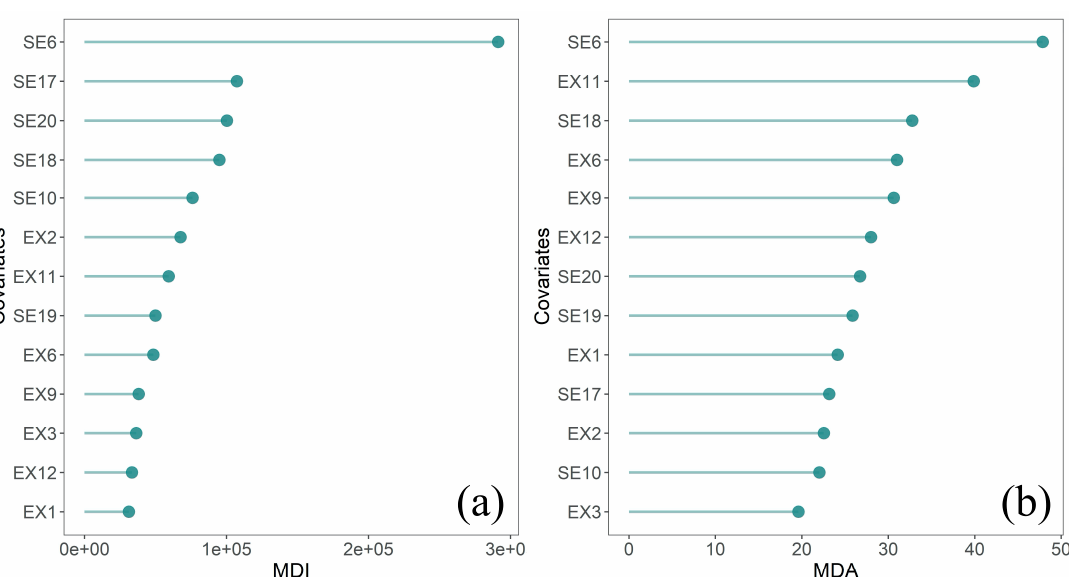
Figure 2. Variables’ relative importance evaluated by random forest-based indicators: ( a ) mean decrease impurity (MDI) and ( b ) mean decrease accuracy